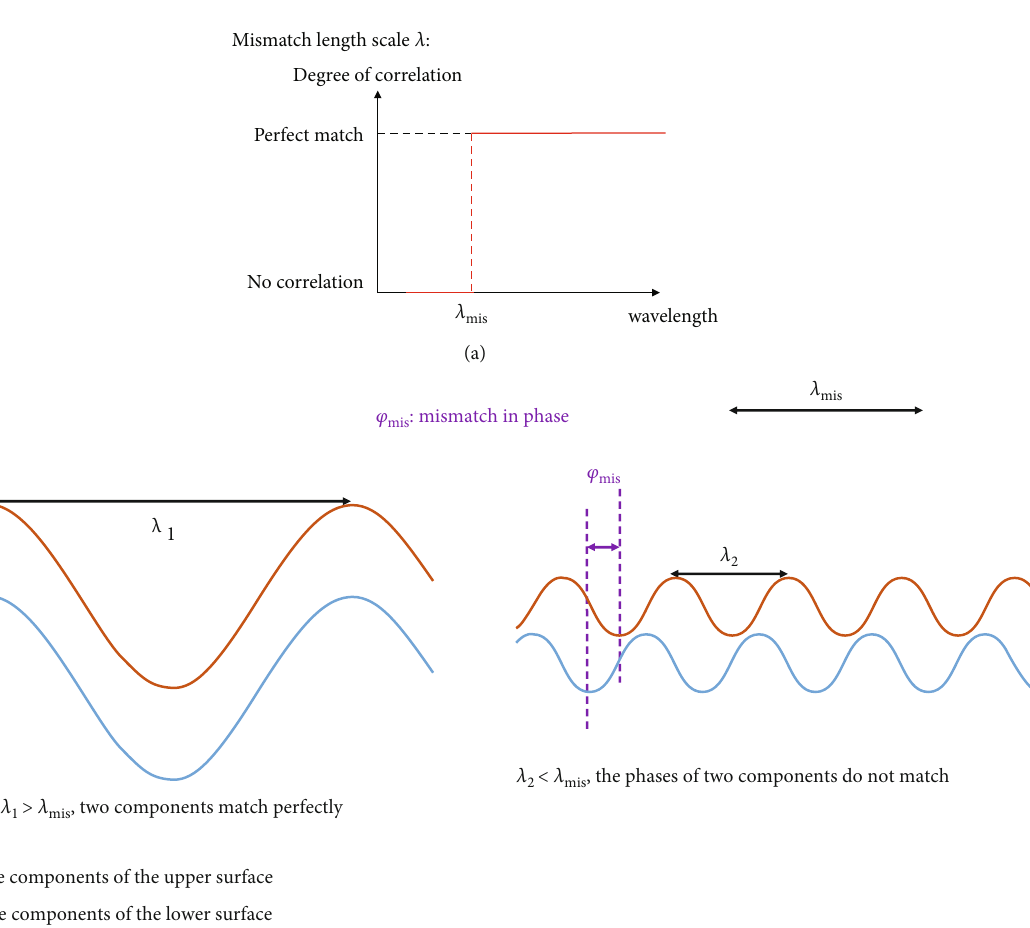
Figure 3: Schematic of mismatch length scale, λ wave components with di ff erent wavelengths. λ λ > λ , and the two components match perfectly. For the right wave components, λ 1 mis components do not match (they are independent). φ